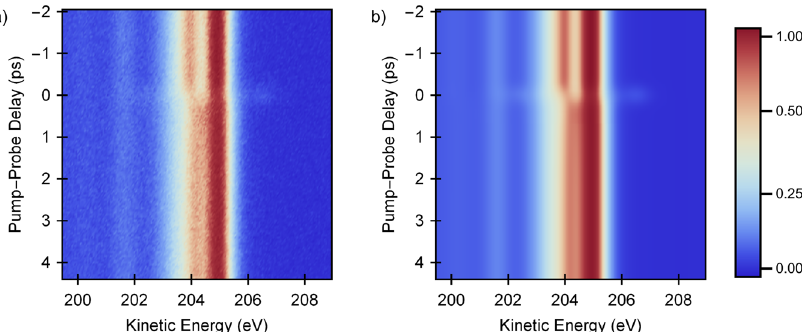
Fig. 3 2D false-color maps of the measured time-dependent C 1 s signal and the fi t. a Measured femtosecond time-resolved C 1 s -XPS spectra of the CuPc: C 60 heterojunction as a function of time-delay (vertical) and kinetic energy (horizontal). b Result of a global fi t procedure that decomposes the heterojunction spectra into contributions associated with the two separate components CuPc and C 60 .